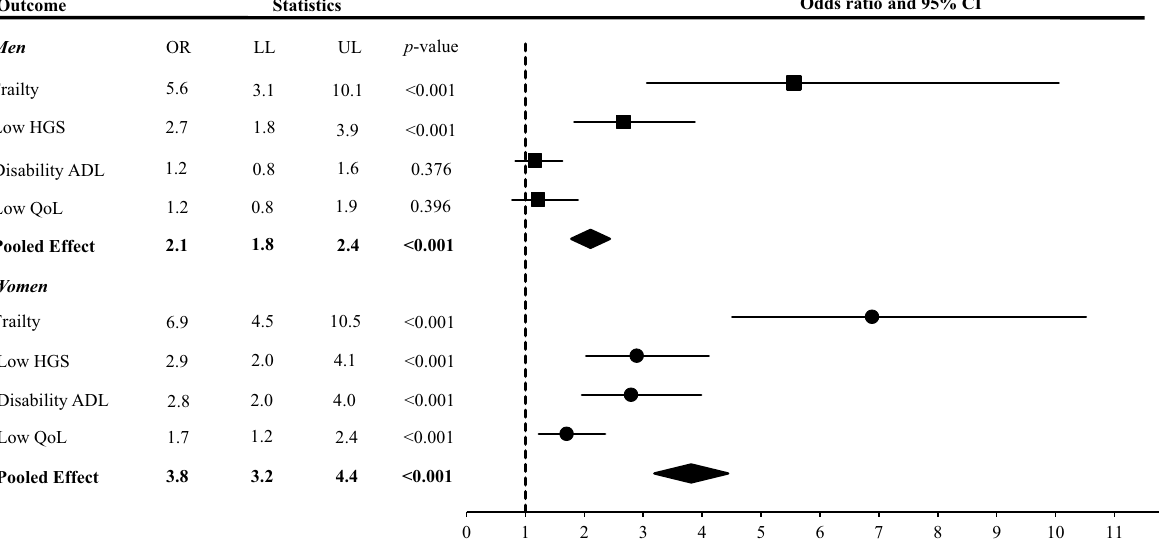
Figure 3. Association between low relative STS muscle power and negative outcomes. The analysis was adjusted by age. Pooled effect size was calculated with frailty (FTS), low HGS, disability ADL and Low Qol. Low HGS low habitual gait speed, Disability ADL disability in one or more activities of the daily living (instrumental and basic combined), Low Qol low quality of life.